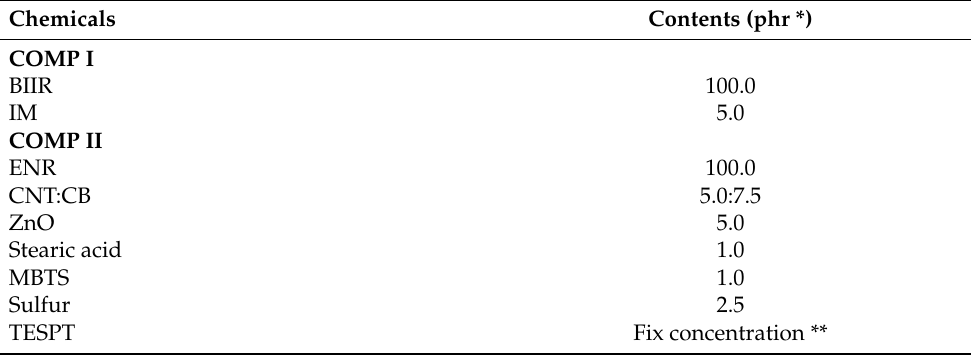
Table 1. Formulation design of the pure rubber and their